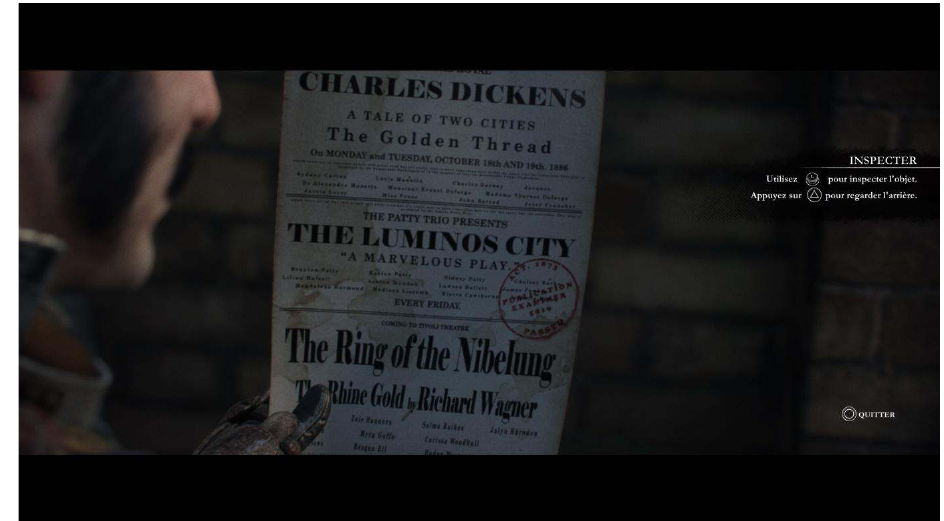
Figure 3: A realistic flyer found in the